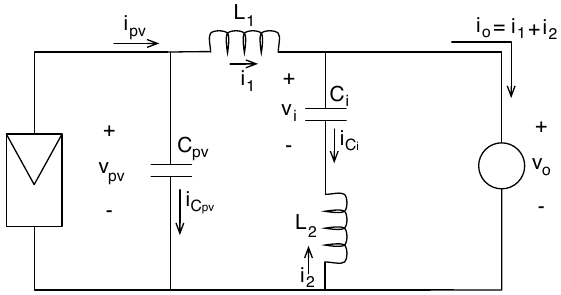
Figure 2. Topology 1 of the PV system based on the CIOC buck converter.